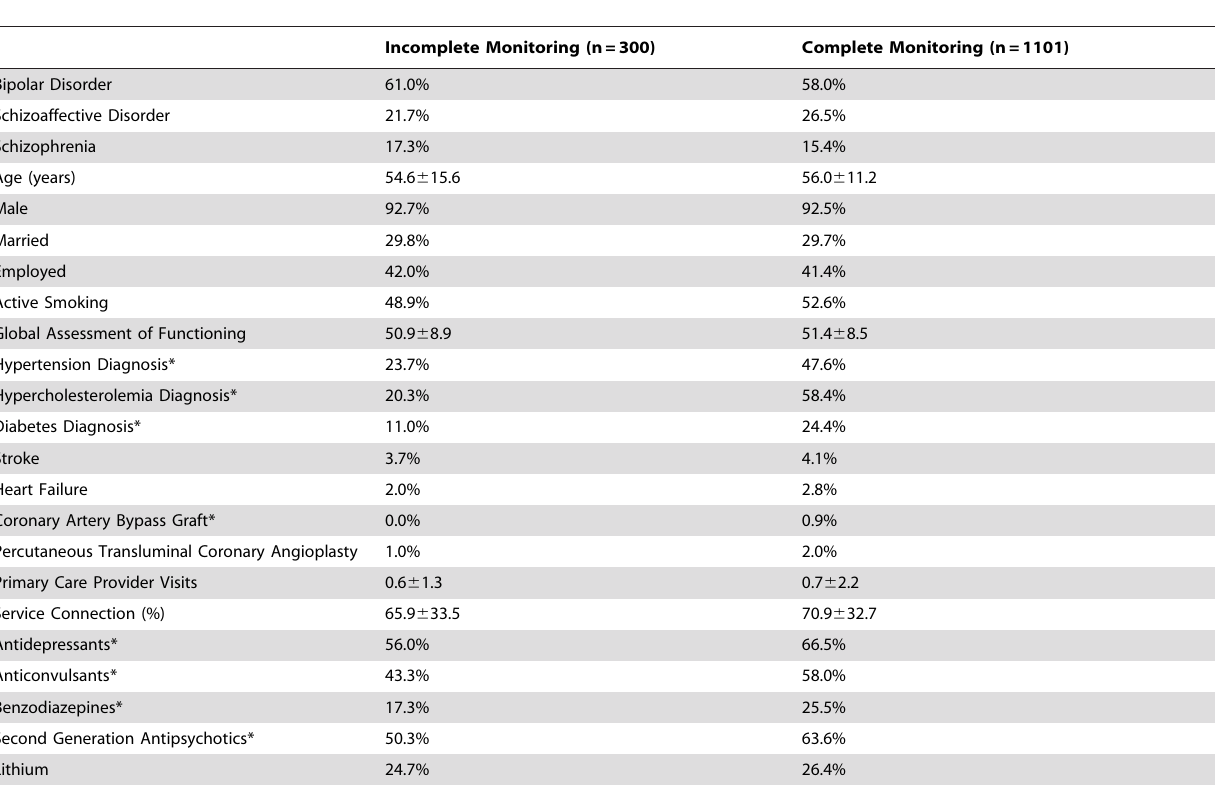
Table 3. Clinical and Demographic Characteristics of Patient Population by Metabolic Syndrome Monitoring